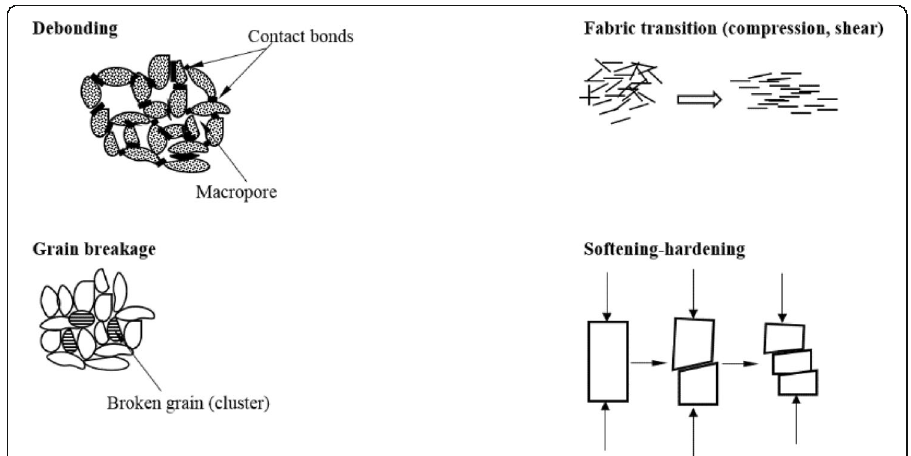
Fig. 3 Mechanisms of collapse (redrawn after Feda